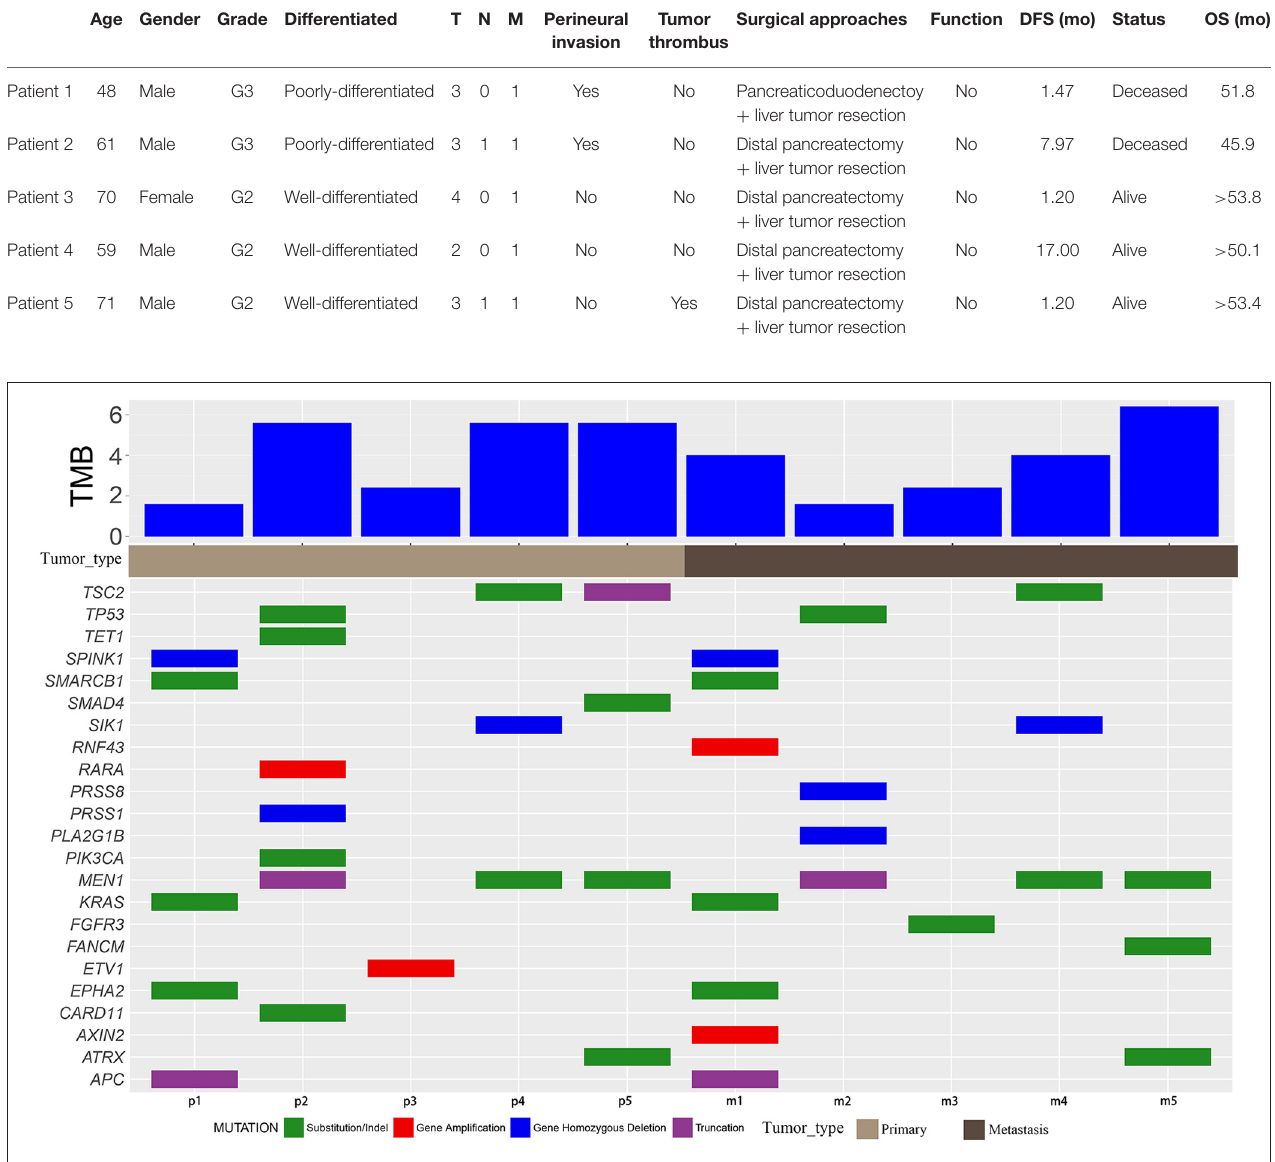
TABLE 1 | Characteristics of the five patients. Age Gender Grade Differentiated T N M Perineural